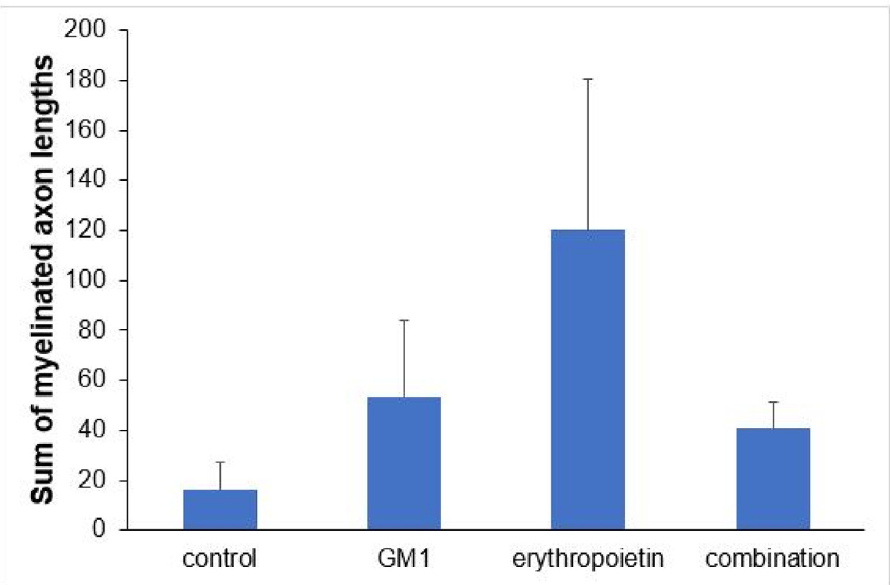
Fig. 5. Mean values and respective standard errors of the sum of axon lengths per group.